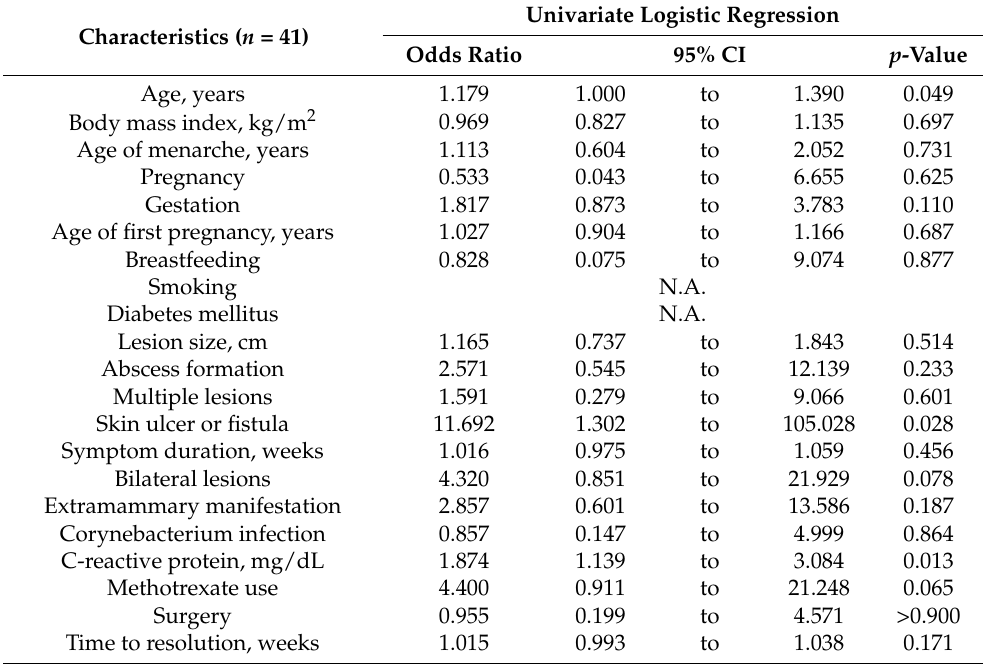
Table 5. Factors associated with recurrence in patients with idiopathic granulomatous